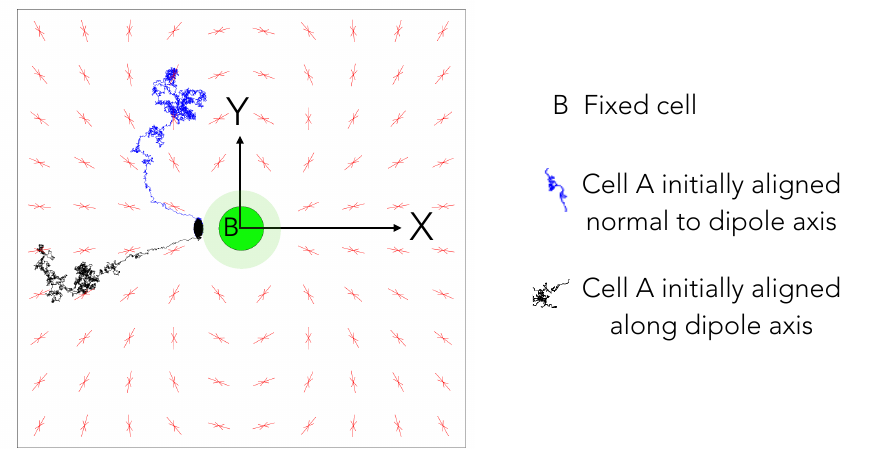
Figure 7. Dipolar cell orientation and trajectory. The equilibrium orientation of contractile cells fixed in position, but free to reorient, and that are uniformly distributed in a square box of size 10 σ , are depicted by two arrows (red) pointing towards each other. Each cell is influenced by the central stationary cell B (green) and not by each other. Two possible trajectories of cell A (blue and black) are recorded for D T = 0.1, α = 40 for total time T = 500 with time steps of dt = 0.001. The cells did not have any self propulsion or rotational diffusion. The Poisson’s ratio ν of the substrate was considered to be 0.3 for this